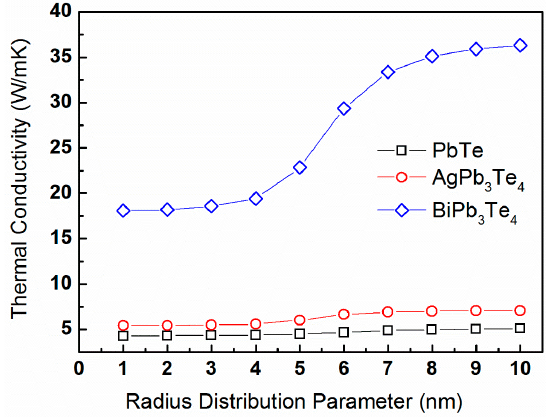
Figure 10. The lattice thermal conductivity of PbTe calculated from expression (16) for constant temperature T = 300 K, average radius R o = 20 nm, and precipitate volume fraction of v f = 5% as a function of the ∆ R -parameter. The calculations are for the PbTe, AgPb 3 Te 4 , and BiPb 3 Te 4 compounds, denoted by black squares, red circles, and blue triangles, respectively.